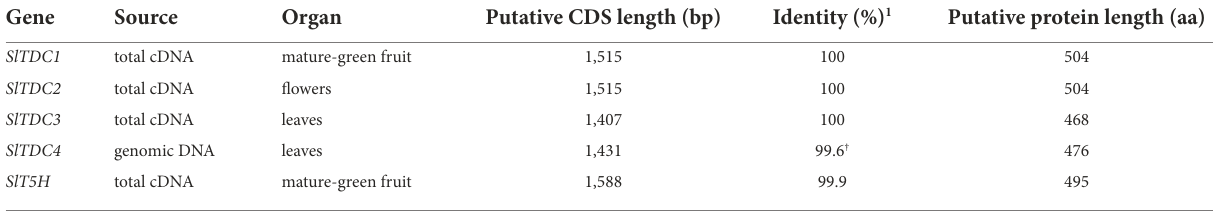
TABLE 2 Structural features of the SlTDC genes cloned from Micro-Tom cDNA or genomic